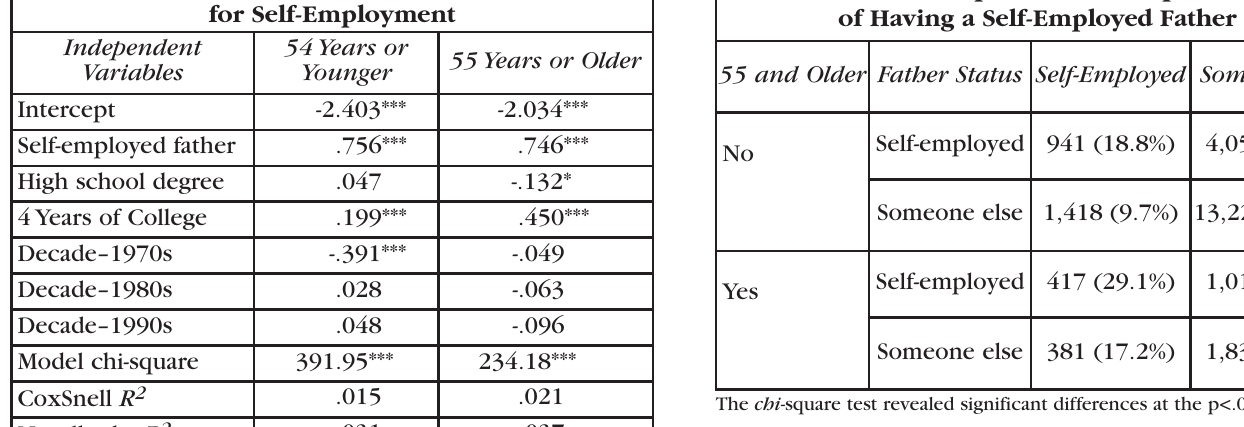
Table 6. Logistic Regression Results Table 7. Chi -Square Test of Importance